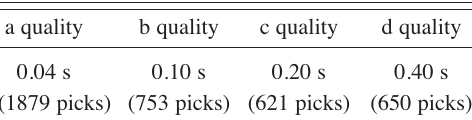
Table II. Picking accuracy quality index assigned to each P - and S